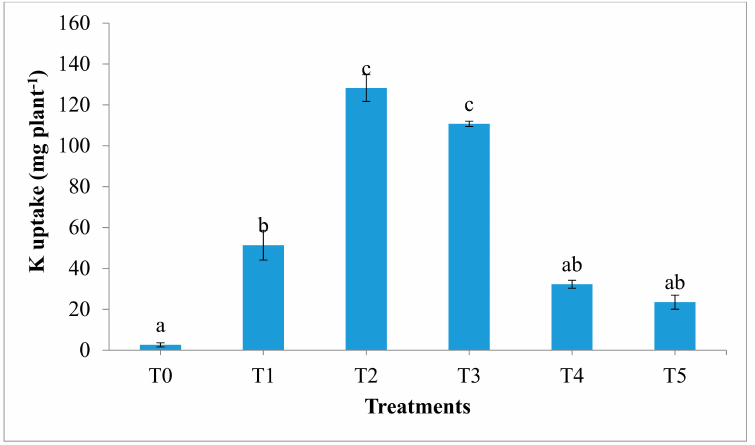
Figure 6. Effects of treatments on total K uptake at harvest (70 DAT). Mean values with different letter(s) indicate significant difference between treatments by Tukey’s test at p ≤ 0.05. Bars represent the mean values ±